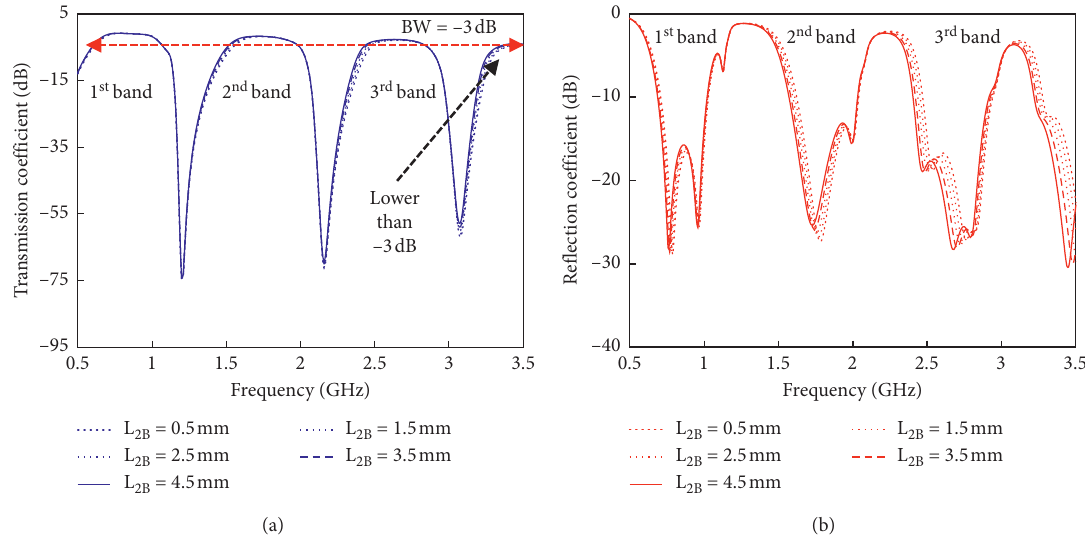
Figure 4: (a) The transmission coefficients ( S 21 ) of the proposed MW-BPF using a QC-SSIR with varied L 2 B values. (b) The reflection coefficients ( S 11 ) of the proposed MW-BPF using a QC-SSIR with varied L 2 B values.